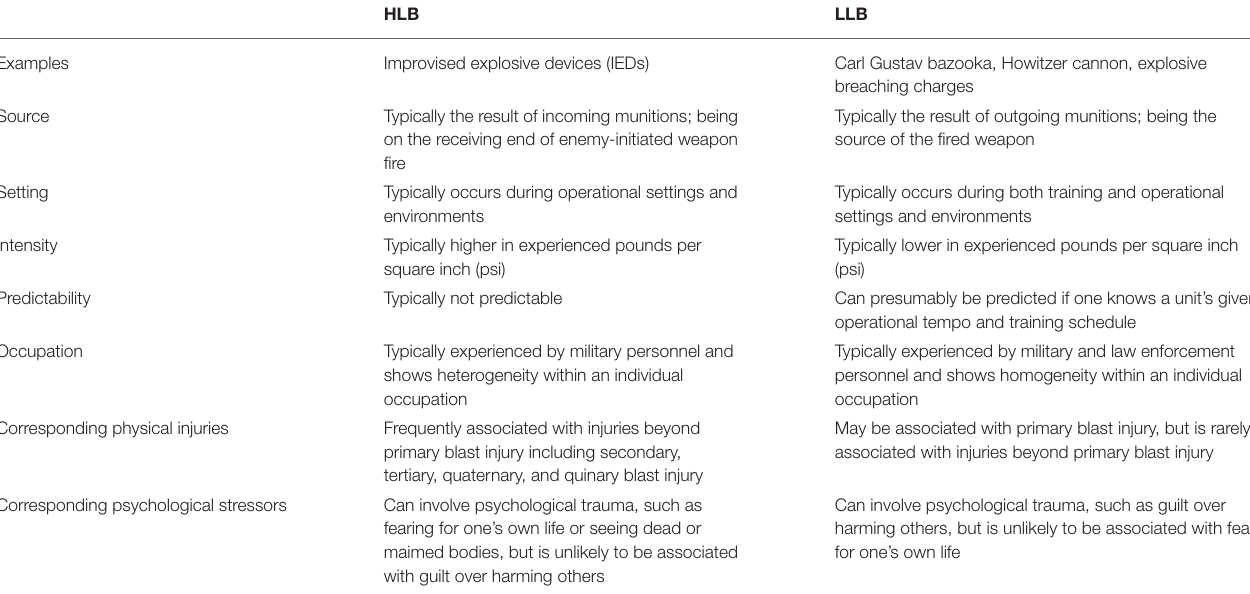
TABLE 5 | Distinctions between high-level blast (HLB) and low-level blast